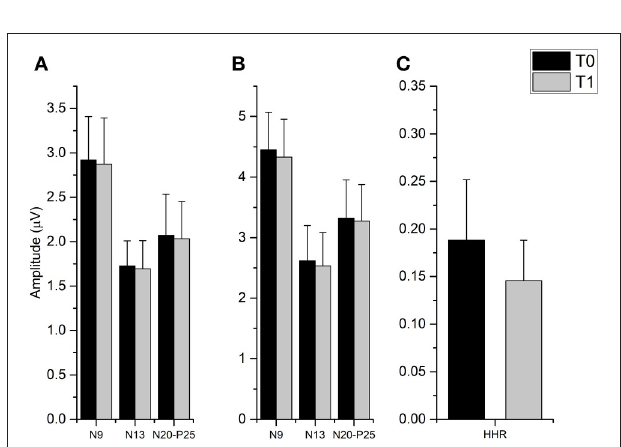
FIGURE 4 | Effect of fMV applied over the FCR muscle on SEP and HHR. fMV has no significant effect on SEP obtained by stimulation the ipsilateral median nerve at the elbow either at 200% (A) and 300% (B) of the somatosensory threshold. By contrast, fMV induced a significant decrease in the amplitude of HHR ( p = 0.014) (C) . Error bars indicate standard